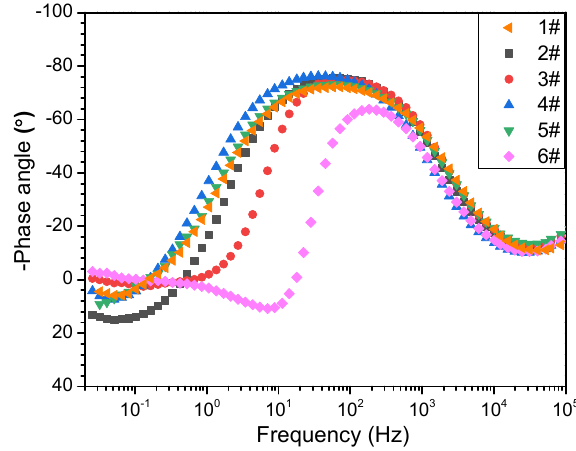
Figure 5. The plots of phase angle and frequency for six alloys. Table 3. Open circuit potential and current efficiency of anode sample by adding Ga.